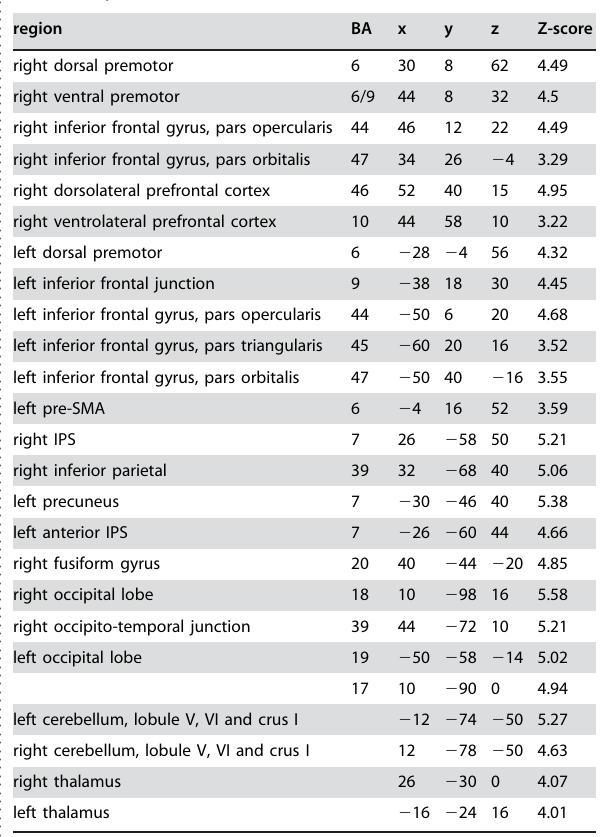
Table 2. Peak voxel coordinates in MNI space and z-values for the fMRI contrasts revealing the phonological network, as Photo Phonological . rest